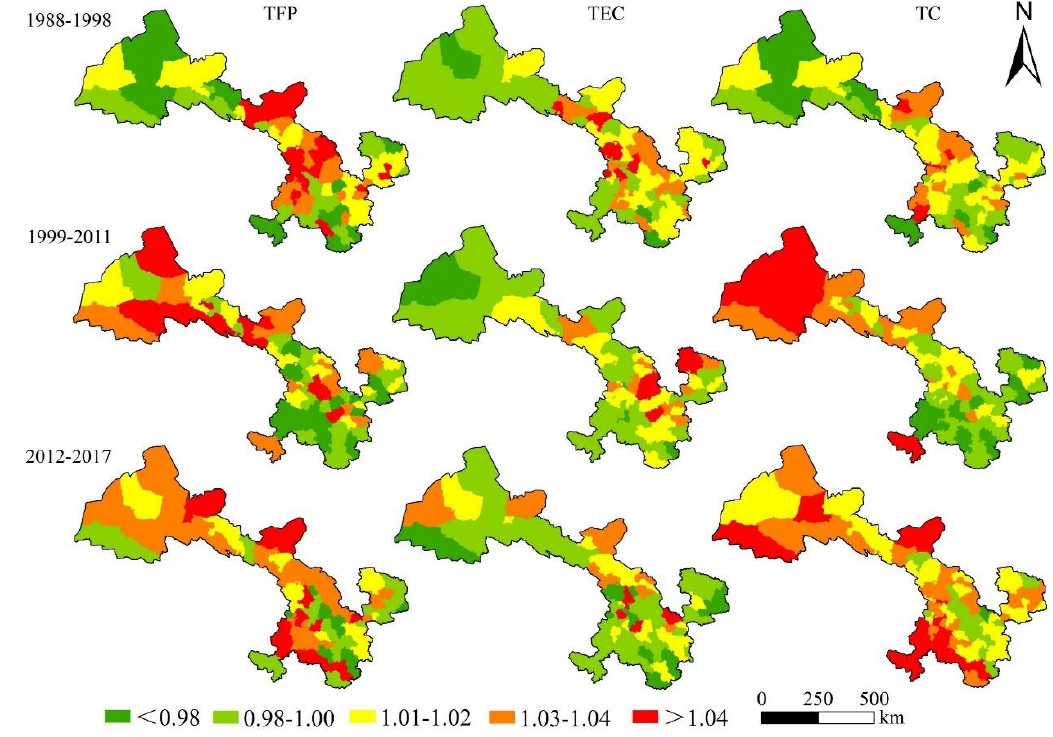
Figure 5. Spatial patterns of TFP, TEC, and TC in Gansu Province from 1988 to 2017.